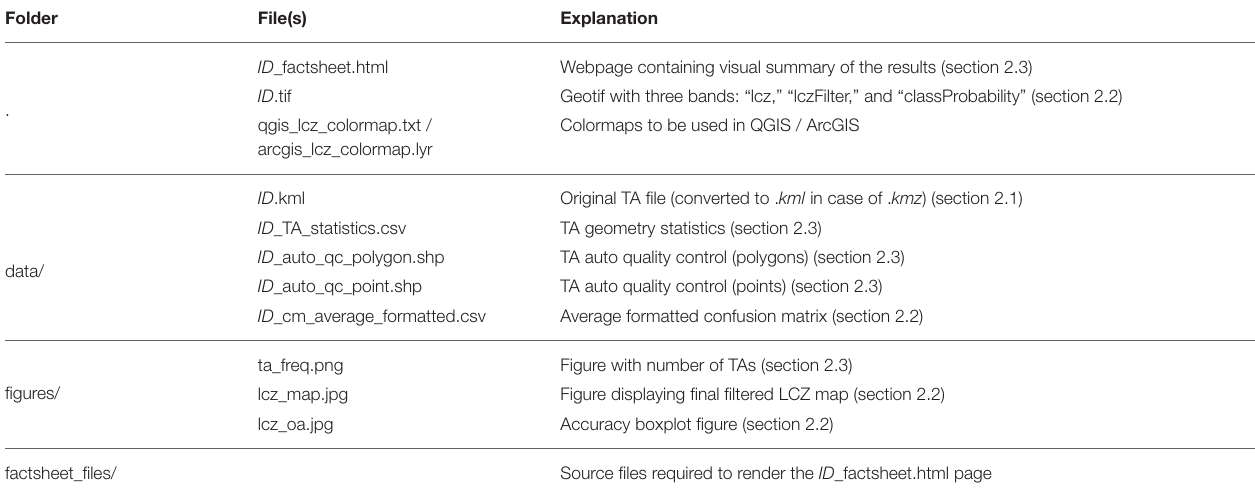
TABLE 3 | File structure and contents of the compressed (. zip ) results send to the user via e-mail.